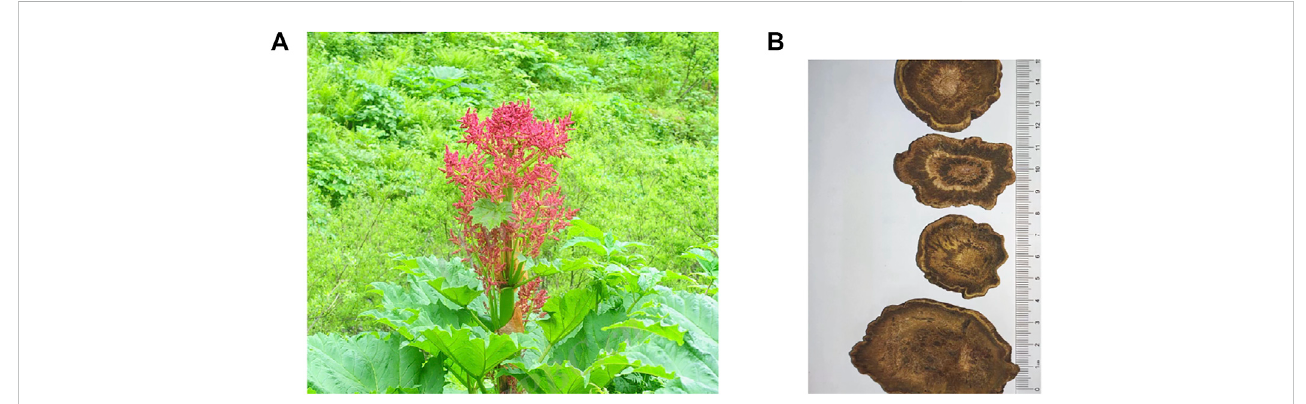
FIGURE 1 Plant and Slice of root of Rheum palmatum L. The leaves of Rheum palmatum L. are palmately lobed to half-lobed, with the lobes mostly narrowly triangular; its fl owers are small, purple-red or yellowish-white; its buds are inverted pyramidal; and its fruits are small. The outer skin of rhubarb is yellowish- brown or reddish-brown, with white-like reticulate texture and scattered stars, and its broken surface is light reddish-brown or yellowish-brown, showing granularity; it has afresh aroma and abitter andslightly astringent taste. (A) Rheum palmatum L. isakind ofherb with medicinal value. (B) prepared slices of Rhubarb, containing a variety of active pharmacological